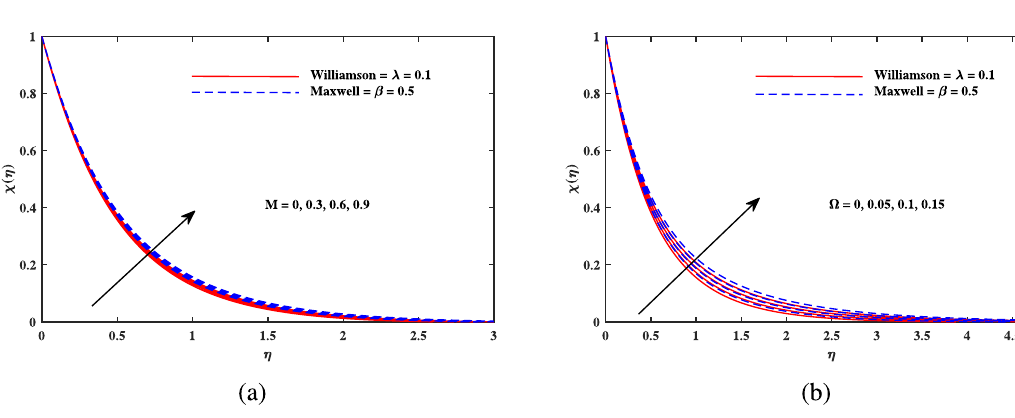
Figure 8. Motile density χ(η) fluctuation with ( a ) M and ( b ) ω .